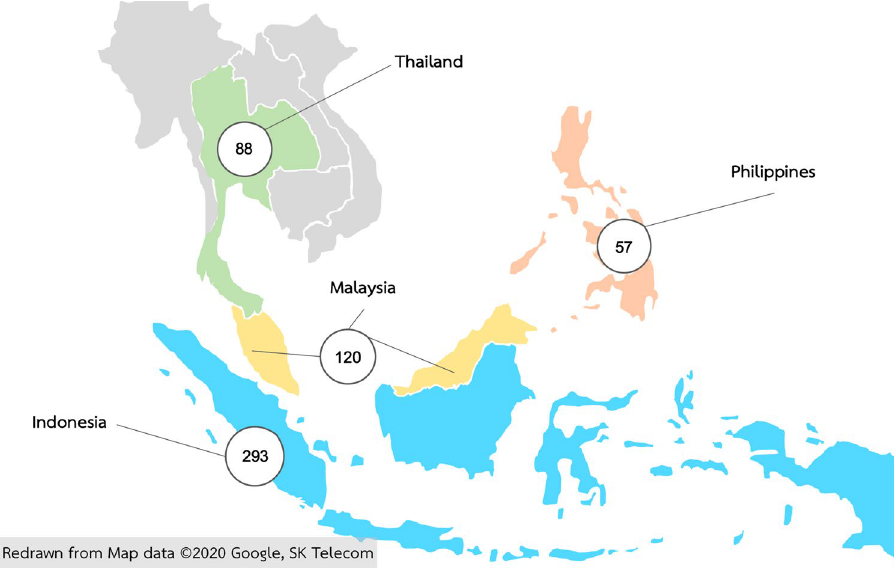
Figure 1. The number of soil samples from the selected Southeast Asian countries which were included in this study. The number in each circle represented the number of samples from each country. The Southeast Asia map was redrawn from “Southeast Asia” map ( Google Maps retrieved 7 May 2020, from https ://www.googl e.com/ maps/@8.27636 09,98.12378